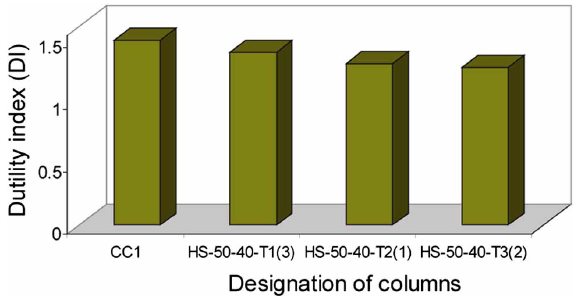
Fig. 21. Ductility Index for columns HS-50-40